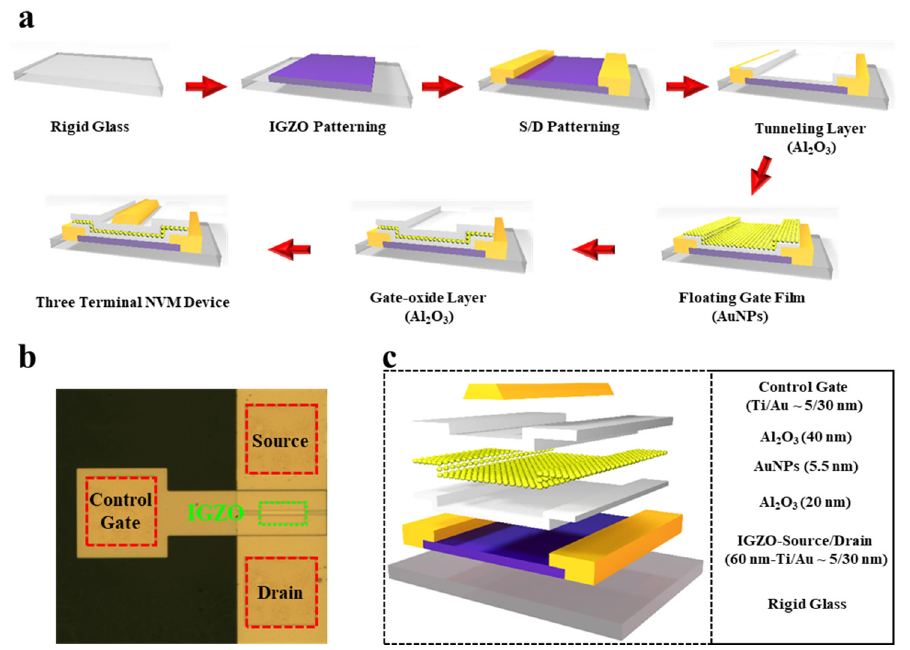
Figure 3. NVM device based on stacking of IGZO/Al 2 O 3 /AuNPs/Al 2 O 3 layers. ( a ) A sequential fabrication process of the proposed NVM devices. ( b ) An optical image of the proposed NVM device. ( c ) A layer-by-layer schematic layout of the proposed NVM device along with each thickness information. Table 1. A comparison of the presented NVM device with the previously reported flash memory devices based on IGZO semiconductor